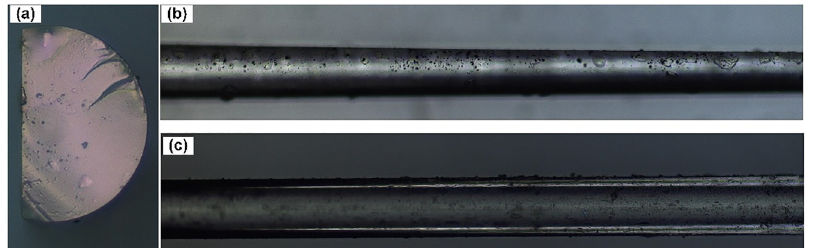
Figure7: (a)Cross-sectionof theDF.(b)Side view and (c) top view of the transition re- gion from the unpolished to the polished part of the